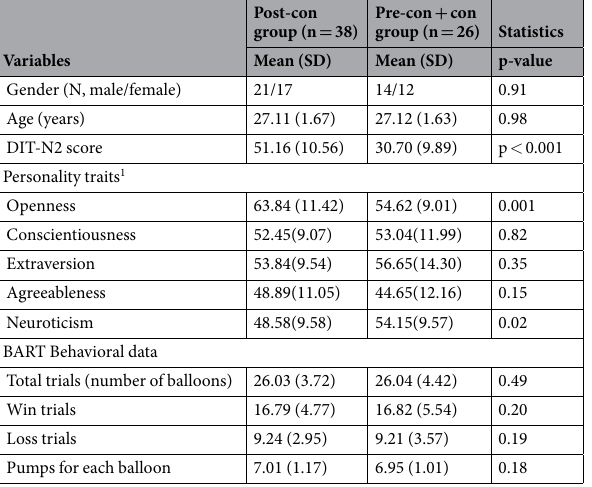
Table 1. Demographic information, personality scores, and behavioral performances. Post-con group, post- conventional group; Pre-con + con group, pre-conventional and conventional group; DIT, Defining Issues Test; BART, Balloon Analogue Risk Task. 1 Personality scores were assessed by NEO-PI-R. Two pre-con + con subjects’ data were not available due to technical reasons.